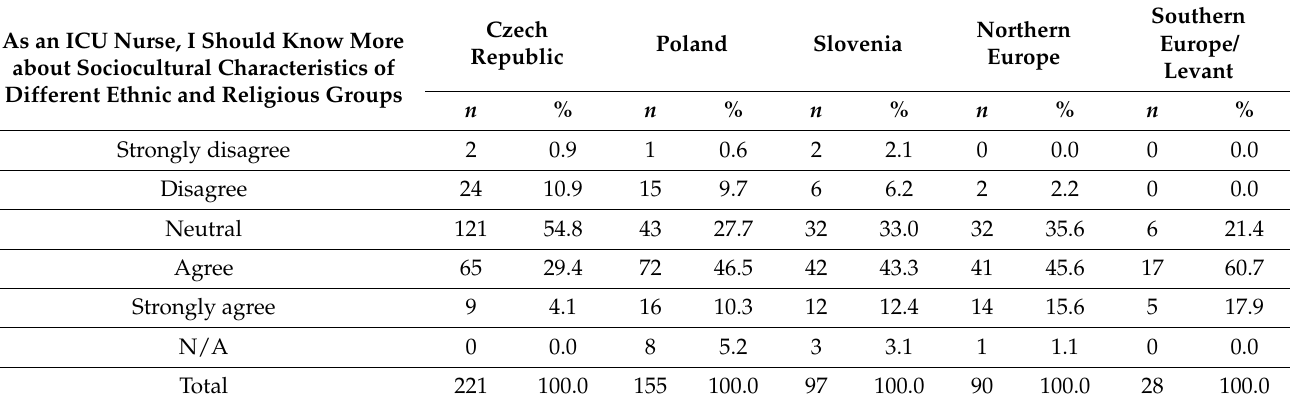
Table 3. Educational needs regarding knowledge/skills of other